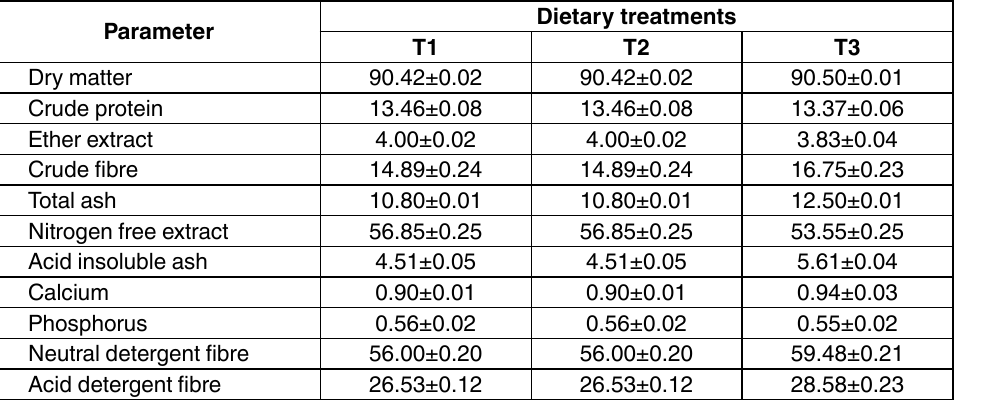
Table 2. Chemical composition 1 of the rations fed to experimental lactating cows, in Percentage